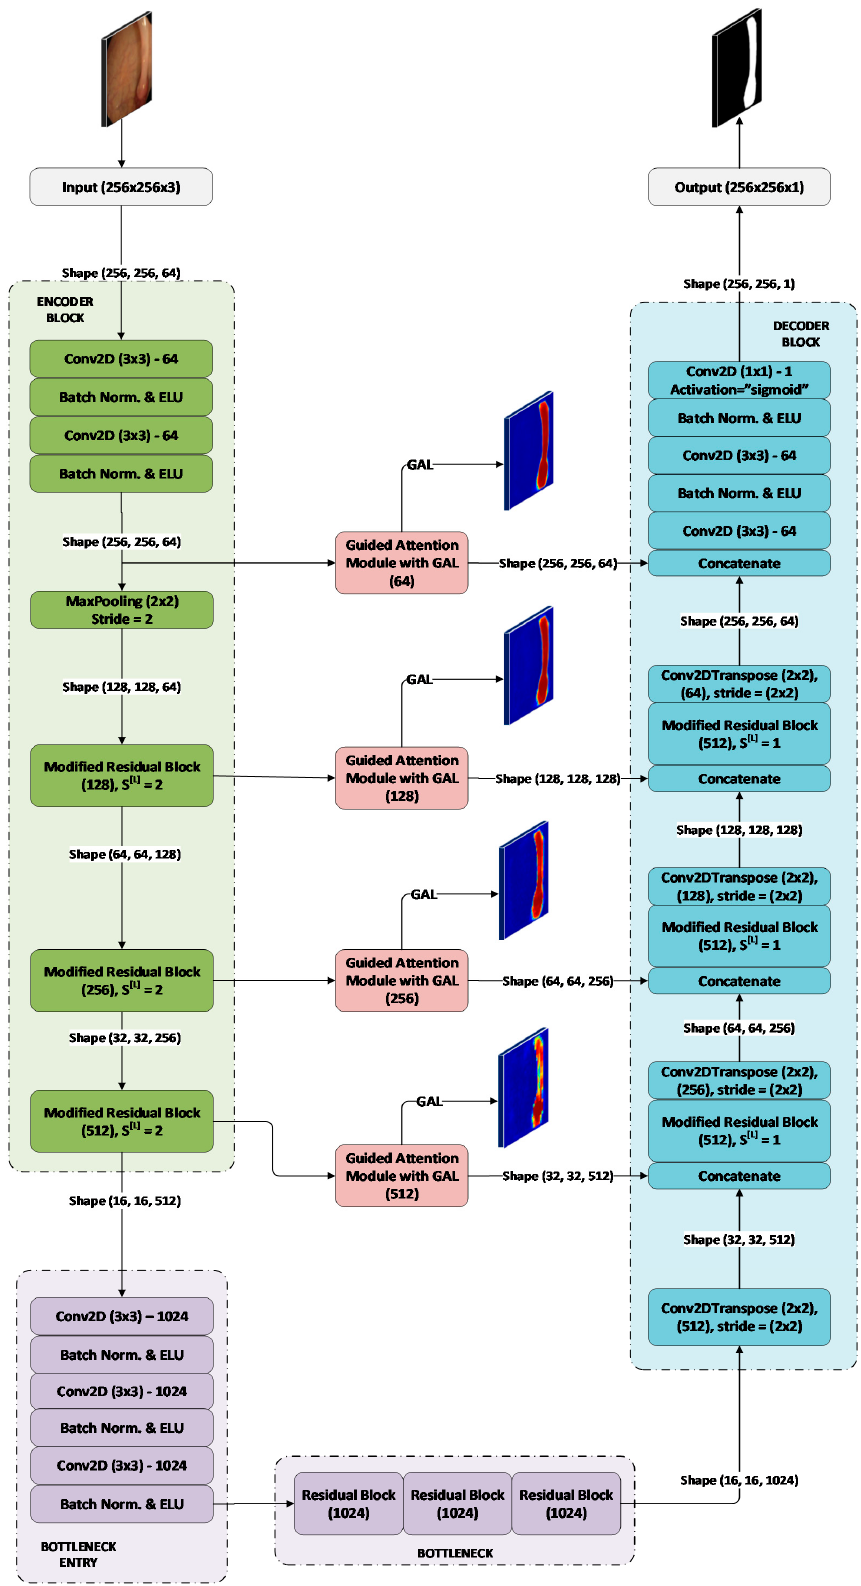
Figure 4. The overview of the proposed GAR-Net